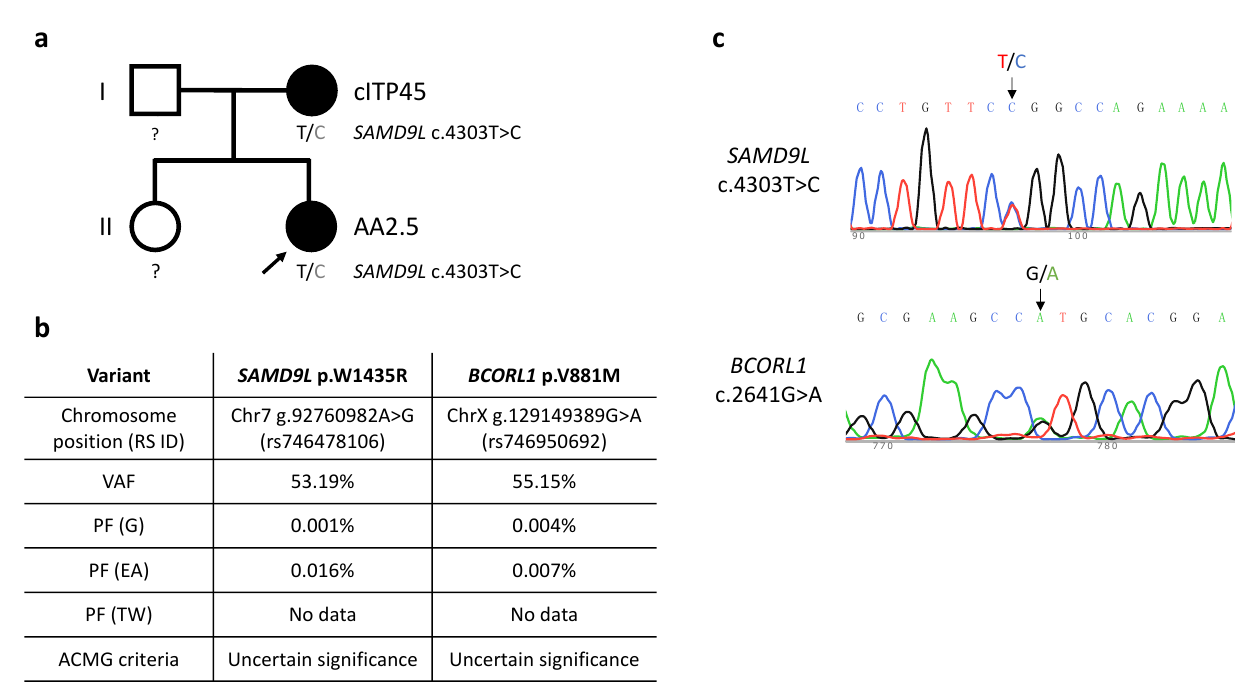
Figure 1. ( a ) Pedigree of the Case 2 family. Black shading represents carriers of the SAMD9L c.4303T>C mutation and presence of relevant disease phenotypes, i.e., cITP45 (chronic immune thrombocytopenia onset at 45 years of age) and AA2.5 (aplastic anemia onset at 2.5 years of age). Squares and circles represent males and females, respectively. ( b ) Characteristics of the detected germline SAMD9L and BCORL1 variants. American College of Medical Genetics and Genomics (ACMG) criteria for variant interpretation encompass a five-tier classification: pathogenic, likely pathogenic, uncertain significance, likely benign, and benign. Data on population frequencies in Taiwan was sourced from Taiwan BioBank. ( c ) Sanger DNA sequencing of SAMD9L exon 5 on chromosome 7 and BCORL1 exon 4 on chromosome X from peripheral blood cells taken from proband (Case 2) of the studied pedigree.